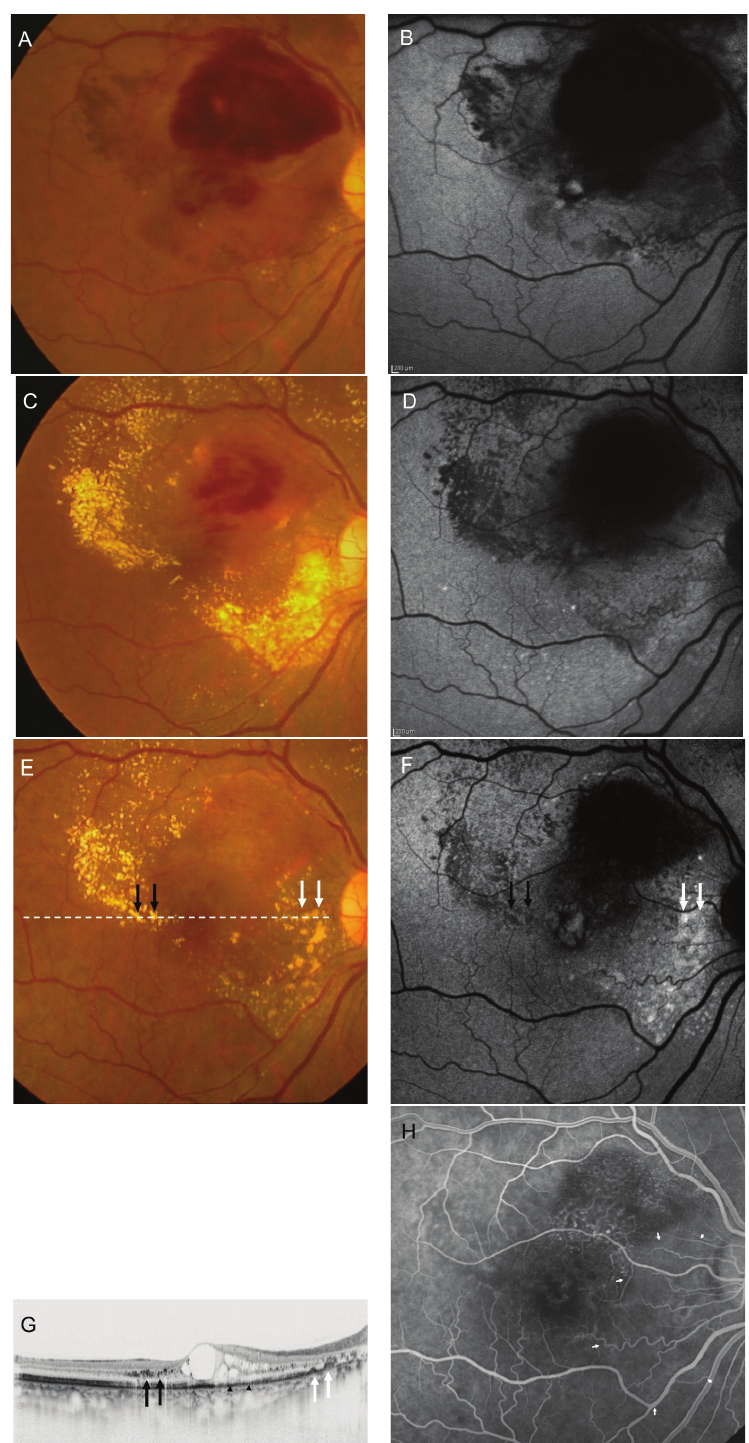
Figure 5: Fundus photograph, fundus autofluorescence, and OCT images for Patient 6 (a 52-year-old woman). The fundus photograph (A) showed a dense retinal hemorrhage and a subretinal hemorrhage. Fundus autofluorescence (B) showed petaloid hyperautofluorescence at the fovea. Extensive exudates were noted 4 months after the first visit (C). Hyperautofluorescence corresponding to the exudates was not observed (D). The color of the exudates in the foveo-papillary area turned yellowish 7 months after the first visit (E). The dashed line indicates the OCT scanning line. Fundus autofluorescence (F) showed hyperautofluorescence in the area corresponding to the yellowish exudates in the foveo-papillary area (white arrows). The exudates in the temporal area (black arrows) showed hypoautofluorescence. OCT (G) at the same visit showed deposits on the retinal pigment epithelium (white arrows) in the foveo-papillary area and intraretinal deposits (white arrows) in the temporal area. The IS/OS disappeared (arrowheads). Fluorescein angiography (H) did not reveal abnormalities in the area corresponding to the area of hyperautofluorescence (white